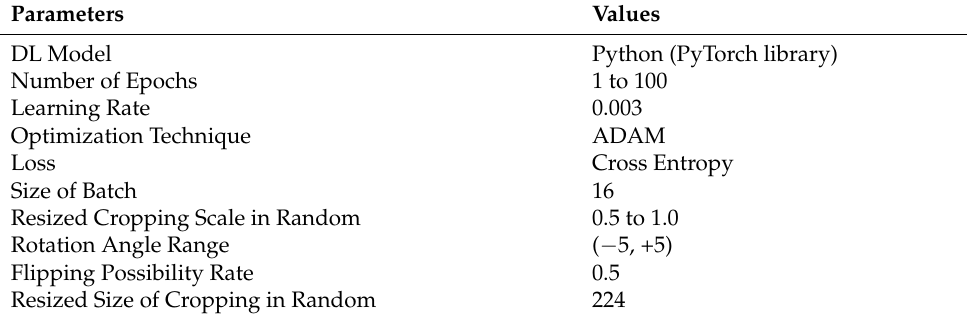
Table 2. Simulation